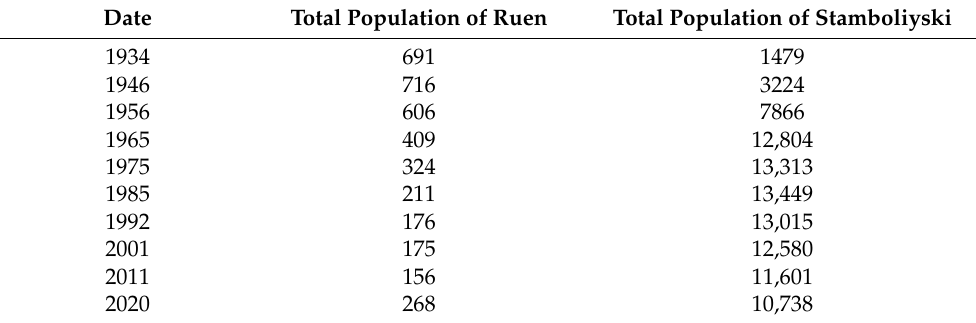
Table 1. Total populations of Ruen and Stamboliyski. All the dates and figures are from national population censuses, except for 2020, which is based on national population estimates.